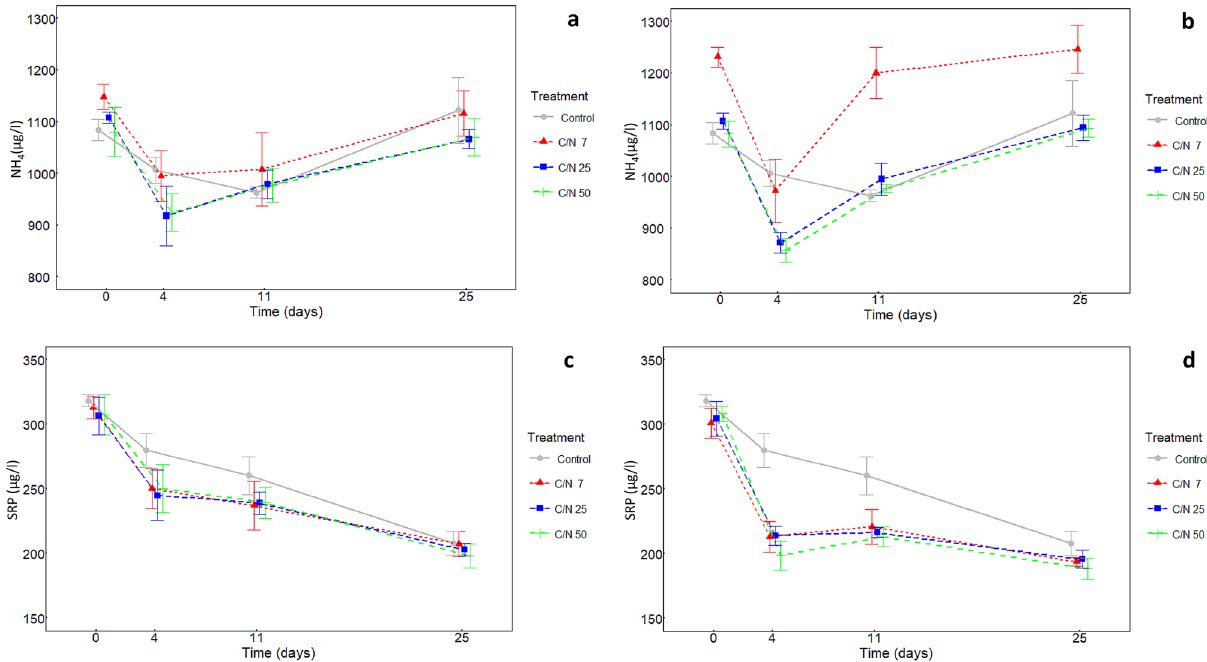
Figure 2. Ammonium N (NH 4 ) concentration in control samples and samples amended by artificial exudates with different C/N ratios ( A ) in concentration of 2% of total DOC and ( B ) in concentration of 5% of total DOC during 25 days incubation. ( C ) Soluble reactive phosphorus (SRP) concentration in control samples and samples amended by artificial exudates with different C/N ratios in concentration of 2% of total DOC and ( D ) in concentration of 5% of total DOC during 25 days incubation (means, ± standard deviations, n = 4).